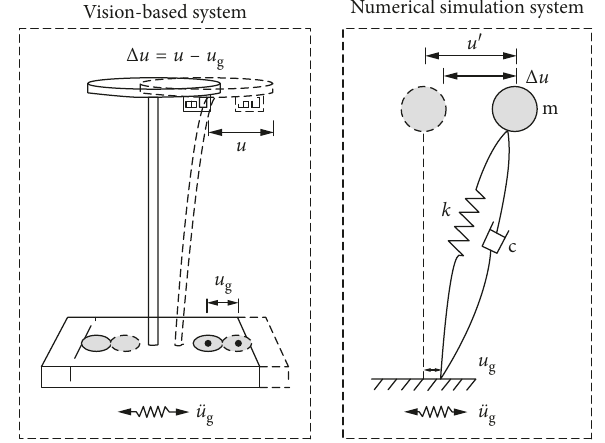
Figure 1: The basic principle of the method. (a) Vision-based system. (b) Numerical simulation